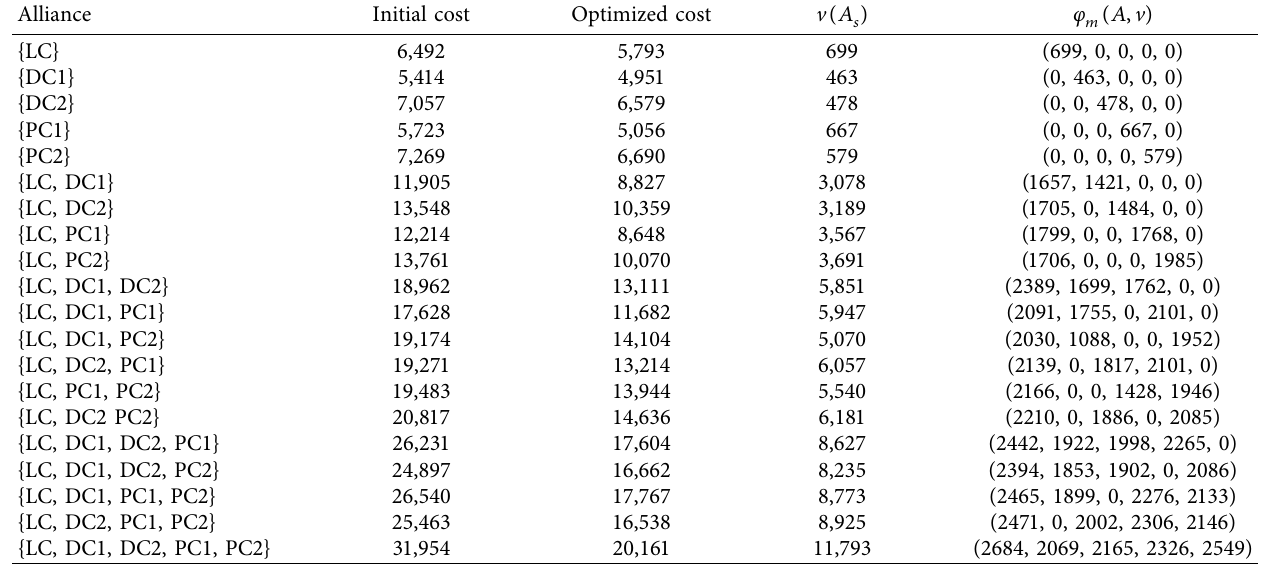
Table 10: Profit of each logistics facility in the 2E-CMDPDTW.